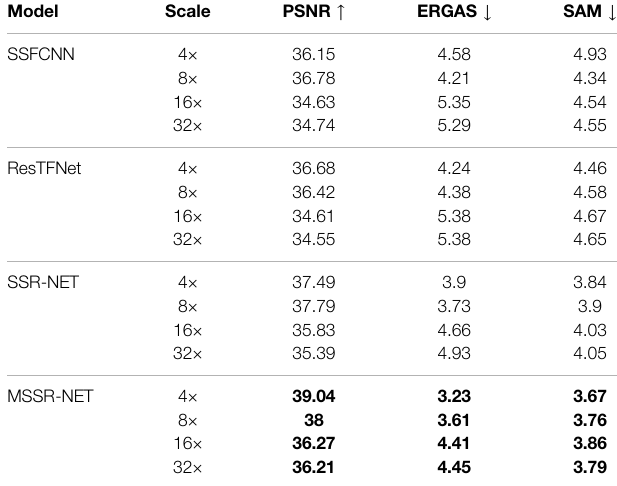
TABLE 4 | Quantitative results on Indian Pines dataset. HR MSI is generated according to Type 1 model. Model